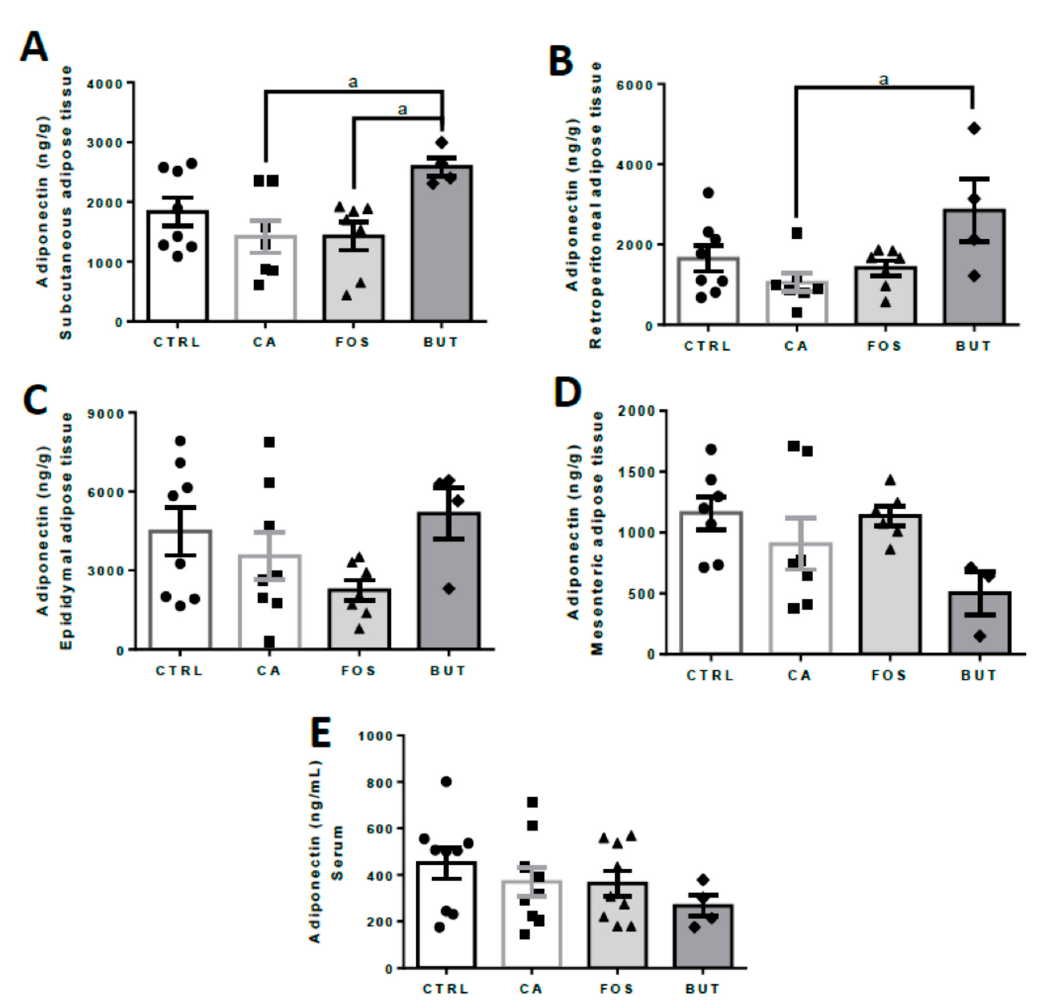
Figure 6. Butyrate elevates adiponectin content in subcutaneous and retroperitoneal adipose tissue: subcutaneous ( A ), retroperitoneal ( B ), epididymal ( C ), and mesenteric ( D ) adipose tissues, and serum ( E ). Mice were divided into four groups: control group (CTRL— n = 7–8) fed with chow diet; and colon carcinogenesis-induced groups fed either with chow diet (CA— n = 7– 8 ), TB-supplemented diet (BUT— n = 4–5), or with FOS-supplemented diet (FOS— n = 7–8). Colon carcinogenesis was induced chemically by azoxymethane (AOM)/dextran sodium sulphate (DSS). Data are presented as means ± SEM. After outlier exclusion, the groups were compared using one-way ANOVA followed by Bonferroni post hoc tests; for p < 0.05 (a); black circles ( ● ), square ( ∎ ), triangles ( ▲ ), rhombus ( ◆ ) represents sample numbers in the corresponding